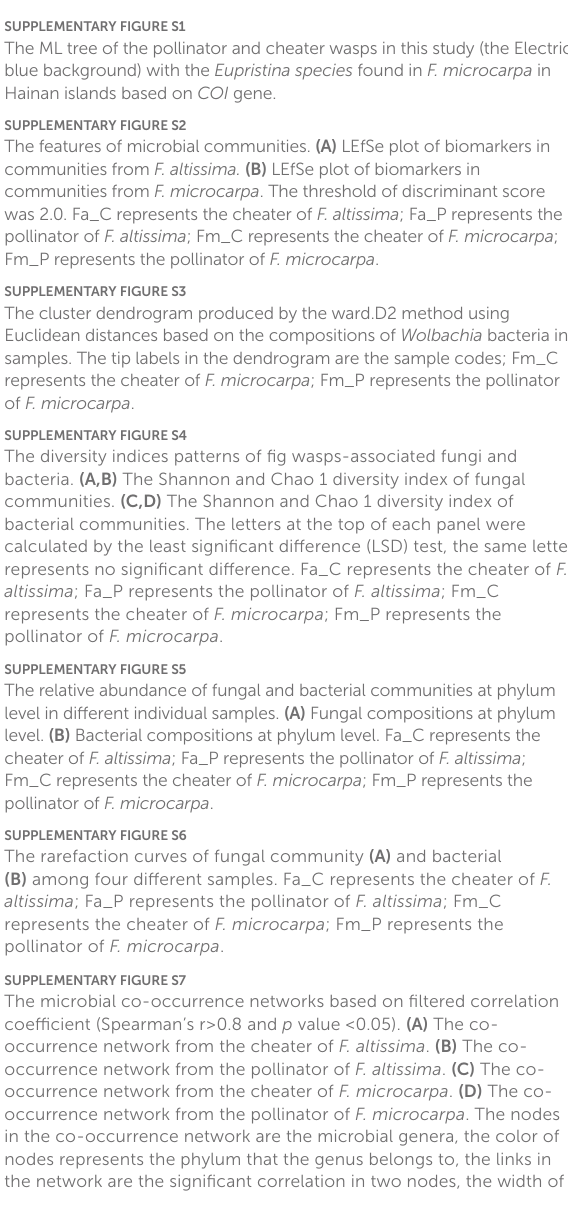
SUPPLEMENTARY FIGURE S1 The ML tree of the pollinator and cheater wasps in this study (the Electric blue background) with the Eupristina species found in F. microcarpa in Hainan islands based on COI gene. SUPPLEMENTARY FIGURE S2 The features of microbial communities. (A) LEfSe plot of biomarkers in communities from F. altissima. (B) LEfSe plot of biomarkers in communities from F. microcarpa . The threshold of discriminant score was 2.0. Fa_C represents the cheater of F. altissima ; Fa_P represents the pollinator of F. altissima ; Fm_C represents the cheater of F. microcarpa ; Fm_P represents the pollinator of F. microcarpa . SUPPLEMENTARY FIGURE S3 The cluster dendrogram produced by the ward.D2 method using Euclidean distances based on the compositions of Wolbachia bacteria in samples. The tip labels in the dendrogram are the sample codes; Fm_C represents the cheater of F. microcarpa ; Fm_P represents the pollinator of F. microcarpa . SUPPLEMENTARY FIGURE S4 The diversity indices patterns of fig wasps-associated fungi and bacteria. (A,B) The Shannon and Chao 1 diversity index of fungal communities. (C,D) The Shannon and Chao 1 diversity index of bacterial communities. The letters at the top of each panel were calculated by the least significant difference (LSD) test, the same letter represents no significant difference. Fa_C represents the cheater of F. altissima ; Fa_P represents the pollinator of F. altissima ; Fm_C represents the cheater of F. microcarpa ; Fm_P represents the pollinator of F. microcarpa . SUPPLEMENTARY FIGURE S5 The relative abundance of fungal and bacterial communities at phylum level in different individual samples. (A) Fungal compositions at phylum level. (B) Bacterial compositions at phylum level. Fa_C represents the cheater of F. altissima ; Fa_P represents the pollinator of F. altissima ; Fm_C represents the cheater of F. microcarpa ; Fm_P represents the pollinator of F. microcarpa . SUPPLEMENTARY FIGURE S6 The rarefaction curves of fungal community (A) and bacterial (B) among four different samples. Fa_C represents the cheater of F. altissima ; Fa_P represents the pollinator of F. altissima ; Fm_C represents the cheater of F. microcarpa ; Fm_P represents the pollinator of F. microcarpa . SUPPLEMENTARY FIGURE S7 The microbial co-occurrence networks based on filtered correlation coefficient (Spearman’s r > 0.8 and p value <0.05). (A) The co- occurrence network from the cheater of F. altissima . (B) The co- occurrence network from the pollinator of F. altissima . (C) The co- occurrence network from the cheater of F. microcarpa . (D) The co- occurrence network from the pollinator of F. microcarpa . The nodes in the co-occurrence network are the microbial genera, the color of nodes represents the phylum that the genus belongs to, the links in the network are the significant correlation in two nodes, the width